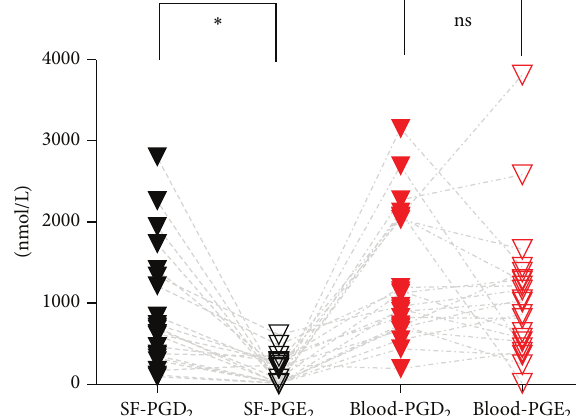
Figure 1: Concentrations of PGD 2 and PGE 2 in synovial fluid